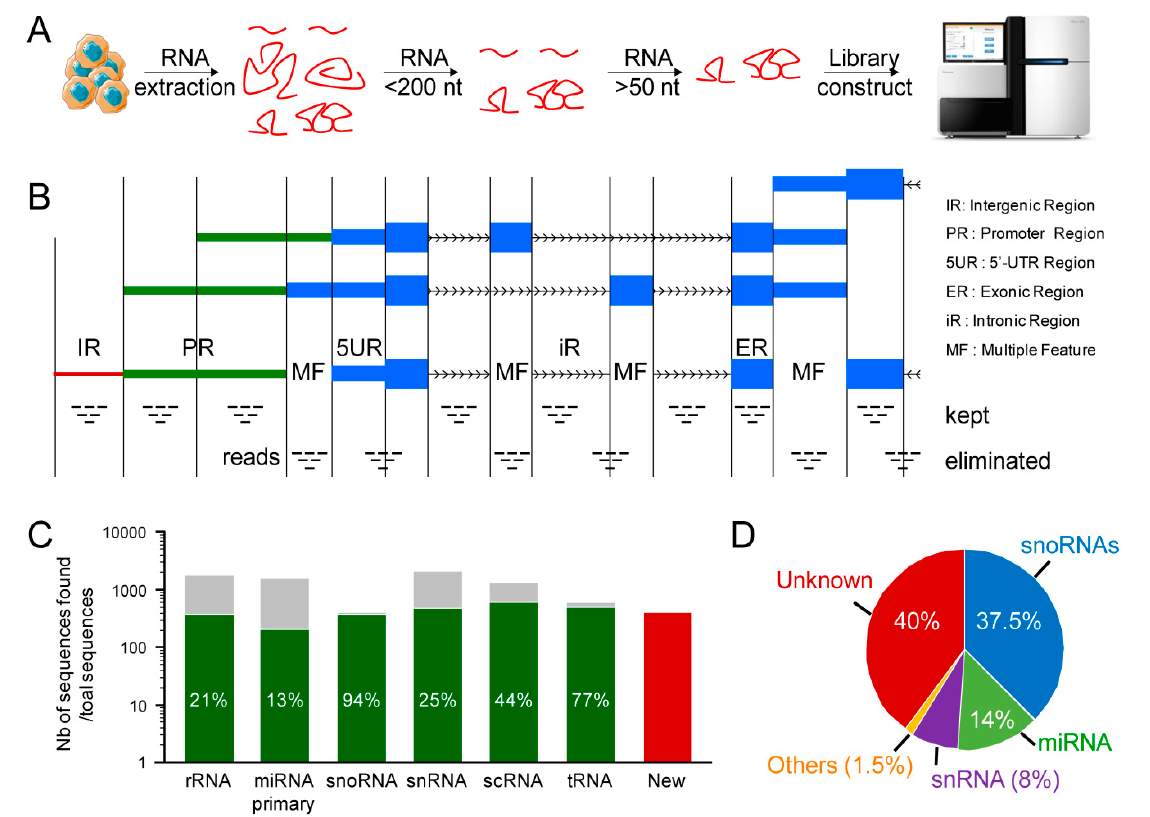
Figure 1. Discovery of new unannotated small non-coding RNAs. ( A ) Schematic representation of the method (see Section 4 for more details). ( B ) Reads that mapped to multiple features, e.g., 5 ′ -UTR and promoter regions, or overlapped with two features for instance, were eliminated from the analysis. Only reads that aligned to unique features were kept for further analysis. ( C ) The number of sequences retrieved (green) out of the total number of known sequences (grey) and the number of new unannotated and yet unknown candidates (red). Only 20% of rRNA was retrieved (there is a rRNA depletion during the preparation of the samples), while 15% of miRNA (the correct proportion of miRNAs for a given cell type) and almost all snoRNA and tRNA were recovered (almost all were ubiquitously expressed). In addition, 400 new candidates were retrieved. ( D ) The percentage of candidates showing homology with already known sequences, sorted by families. For instance, 37.5% of newly identified small ncRNAs showed sequence homology to known snoRNAs. IR, Intergenic Region (red); PR, Promoter Region (green); 5UR, 5 ′ -UTR Region (thin blue); ER, Exonic Region (thick blue); iR, intronic Region (black); MF, Multiple Feature (empty); rRNA, ribosomal RNA; miRNA, microRNA; snoRNA, small nucleolar RNA; snRNA, small nuclear; scRNA, small cytoplasmic RNA; tRNA, transfer RNA; New, new unannotated and yet unknown small RNA candidates.